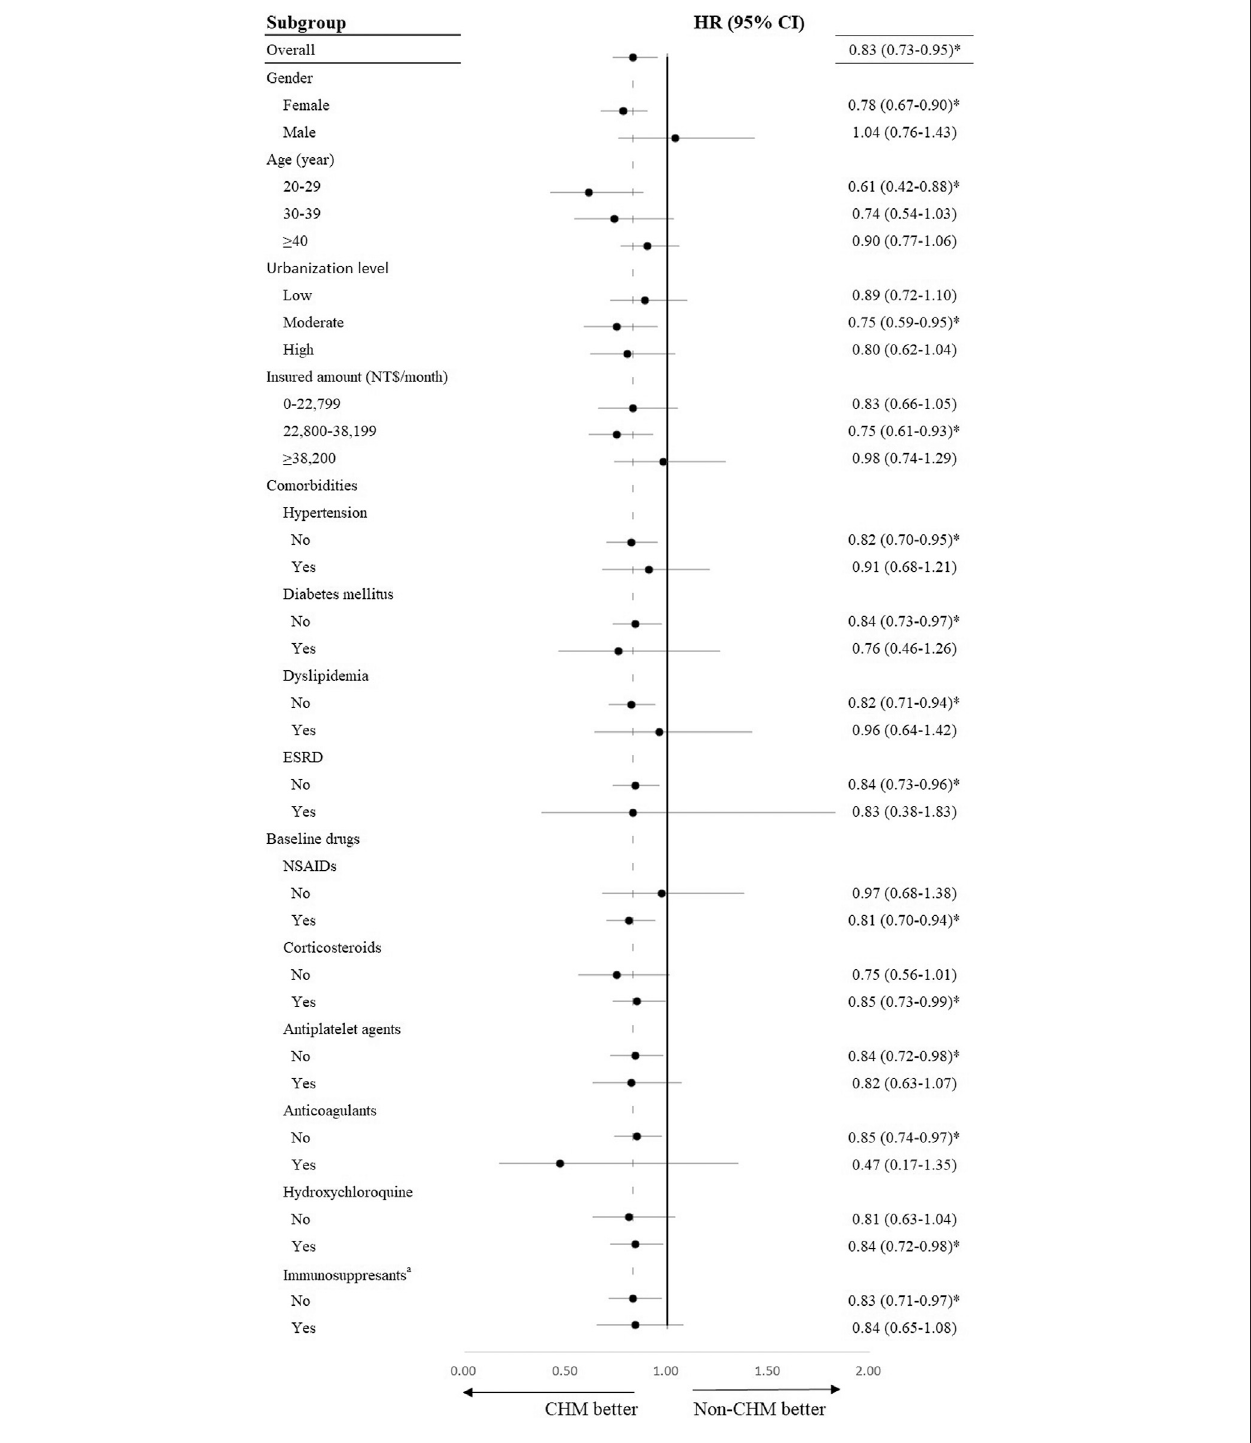
Frontiers in Pharmacology |